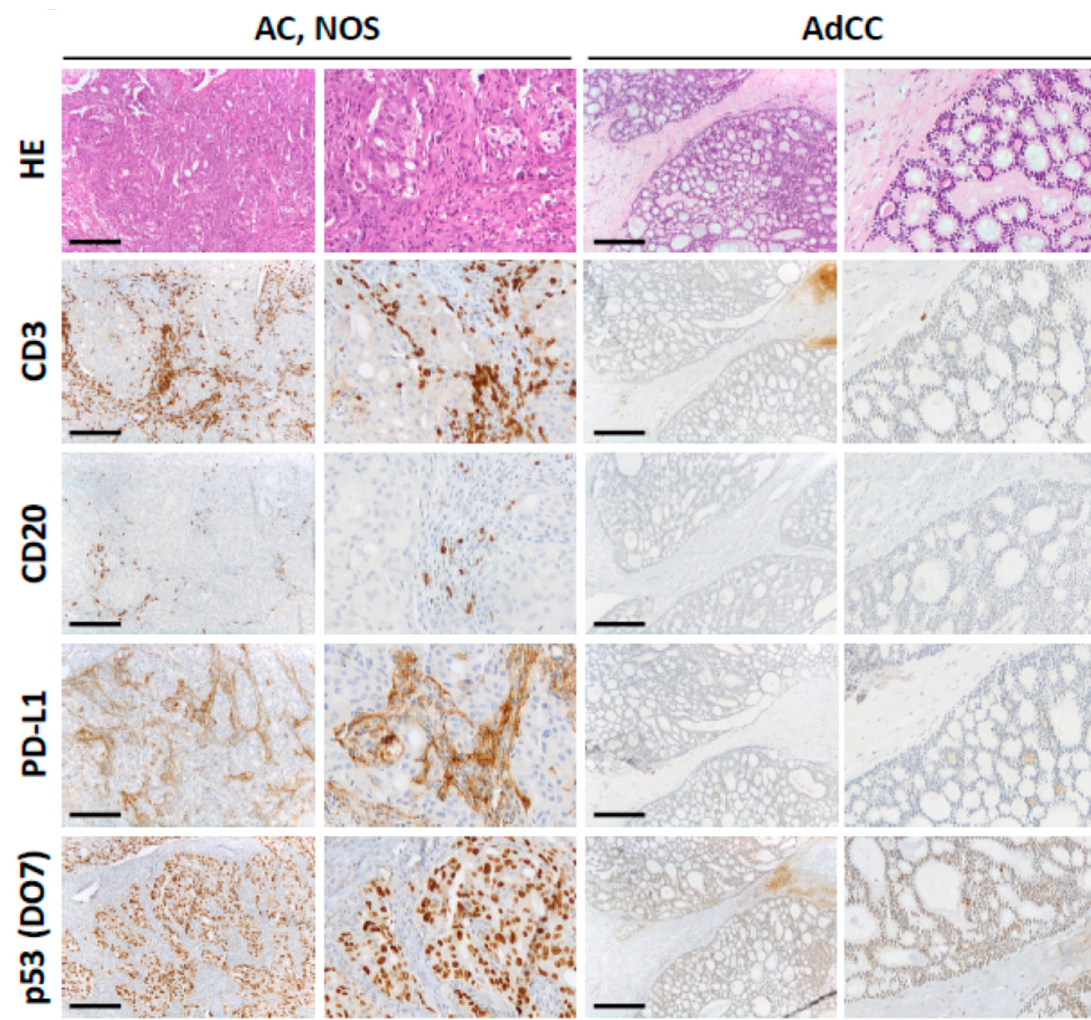
Figure 3. Microphotographs of the immunohistochemistry (IHC) analyses for cluster of differentiation (CD) 3, CD20, programme cell death ligand 1 (PD-L1), and p53 (DO7) in two representative cases of Adenocarcinoma, not otherwise specified (AC, NOS) (case no. 9546/12, left panels including higher magnification) and Adenoid cystic carcinoma (AdCC) (case no. 8738/14, right panels). There is a higher number of tumor-associated lymphocytes (CD3/CD20) and higher PD-L1 expression (Tumor proportional score (TPS) 10, combined positivity score (CPS) 53, immune cell score (IC) 3) in AC, NOS compared to AdCC (TPS 4, CPS 6, IC 1). AC, NOS shows strong nuclear expression of p53 (DO7) while only a few nuclei are positive in AdCC. Scale bar: 200 µm.